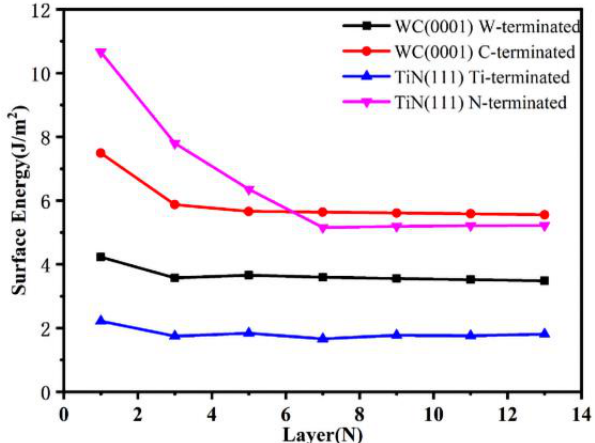
Figure 7. Variation of surface energy with the number of atomic layers for different terminated atomic surface models.